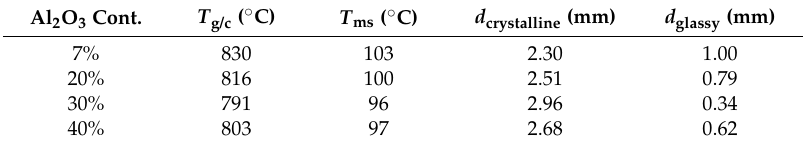
Table 2. Conditions for R int calculations of mold fluxes with different amounts of Al 2 O 3 .